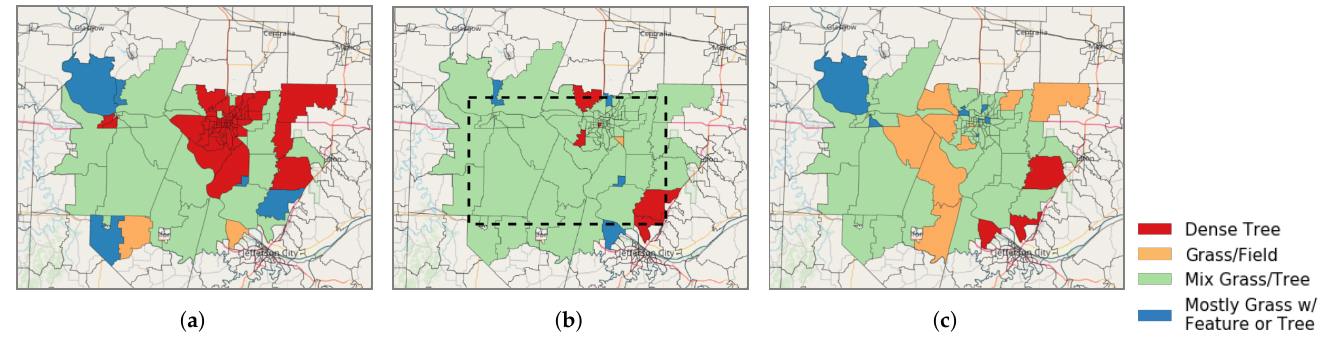
Figure 7. Geographic maps of cluster labeled blocks in the CoMo study area. Each color represents a cluster: ( a ) 2011 map, ( b ) 2015 map, ( c ) 2017 map. The actual study area is surrounded with black dashed rectangle in ( b ) and this is the same study area in ( a , c ). Unlike the blocks that are completely inside the study area, the blocks that are partially inside the study area are based on the partial information. Notice, the block is labeled based on the predominant cluster.